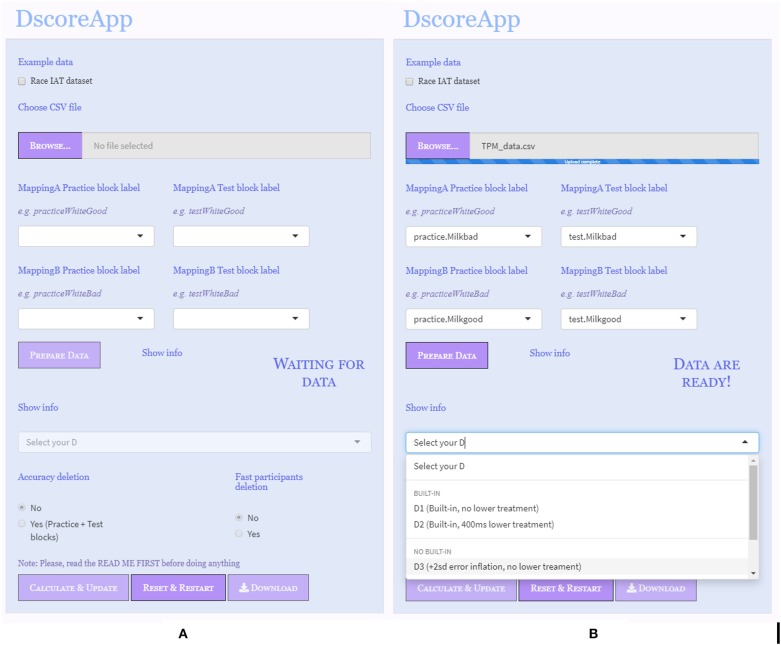
Input panel. (A) Data correctly uploaded. (B) Data ready for computation.